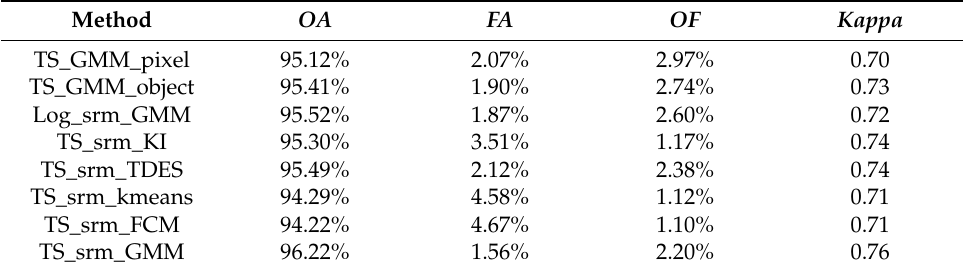
Table 2. Performance evaluation of the change detection over LiangZi